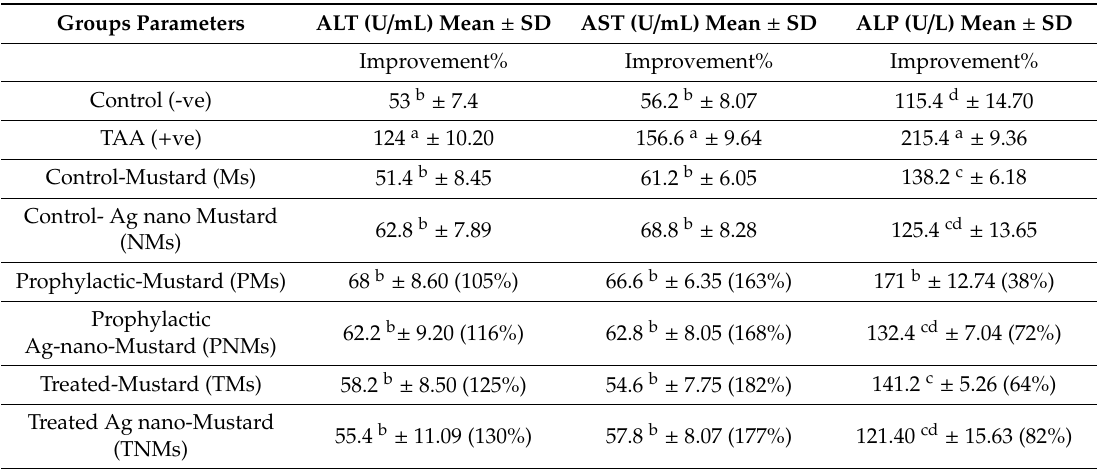
Table 2. Restorative and prophylactic impacts of Brassica juncea L. (mustard) extract in its normal and its nanostructure on liver function